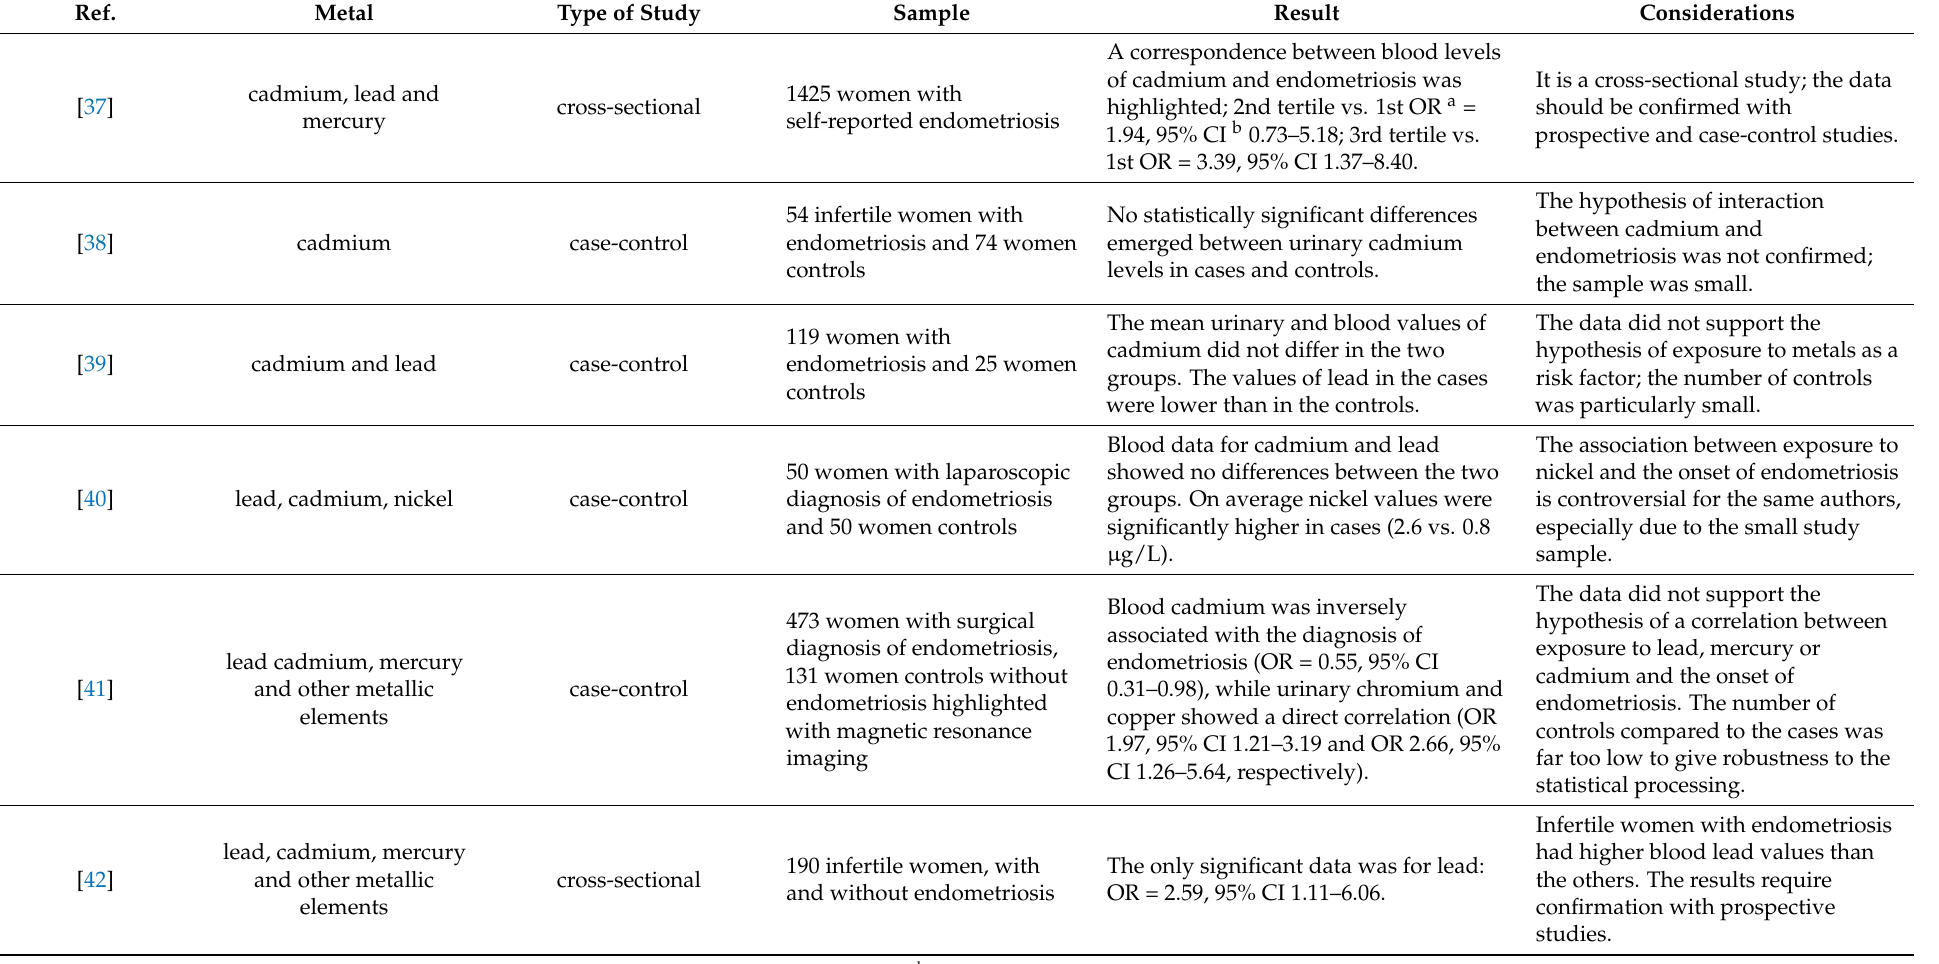
Table 2. Description of the investigations conducted with respect to metals exposure and endometriosis.